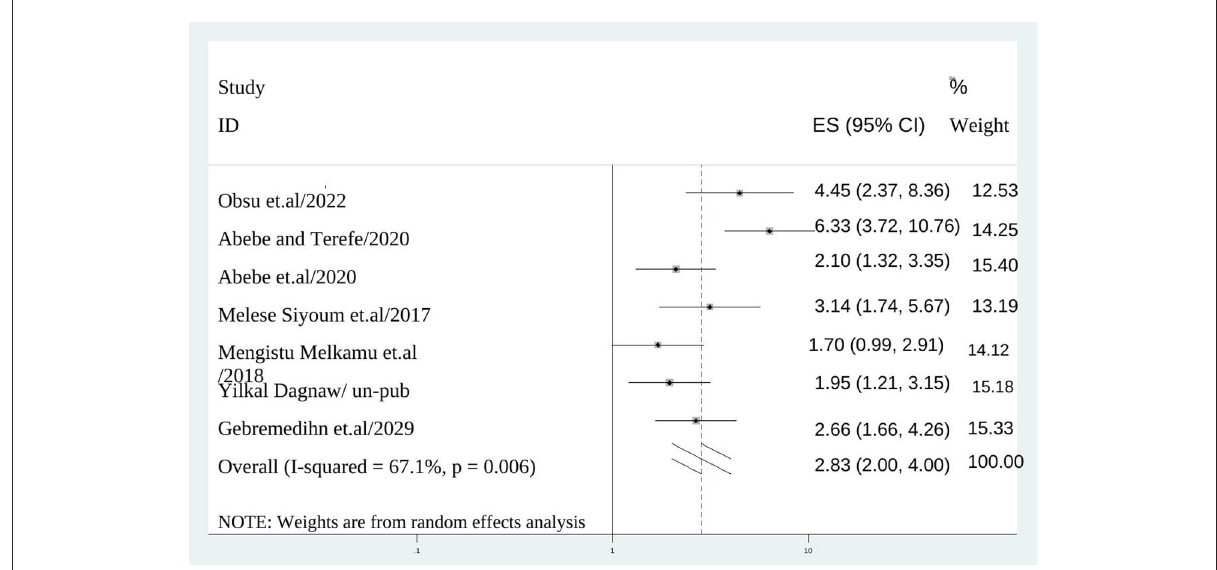
FIGURE4 The association between experiencing side effects and discontinuation of long acting reversible contraception.